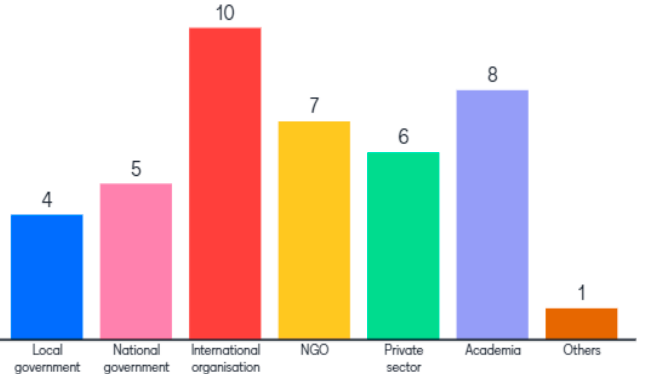
Figure 5. Professional groups of participants during a workshop at the World Urban Forum in Abu Dhabi (February